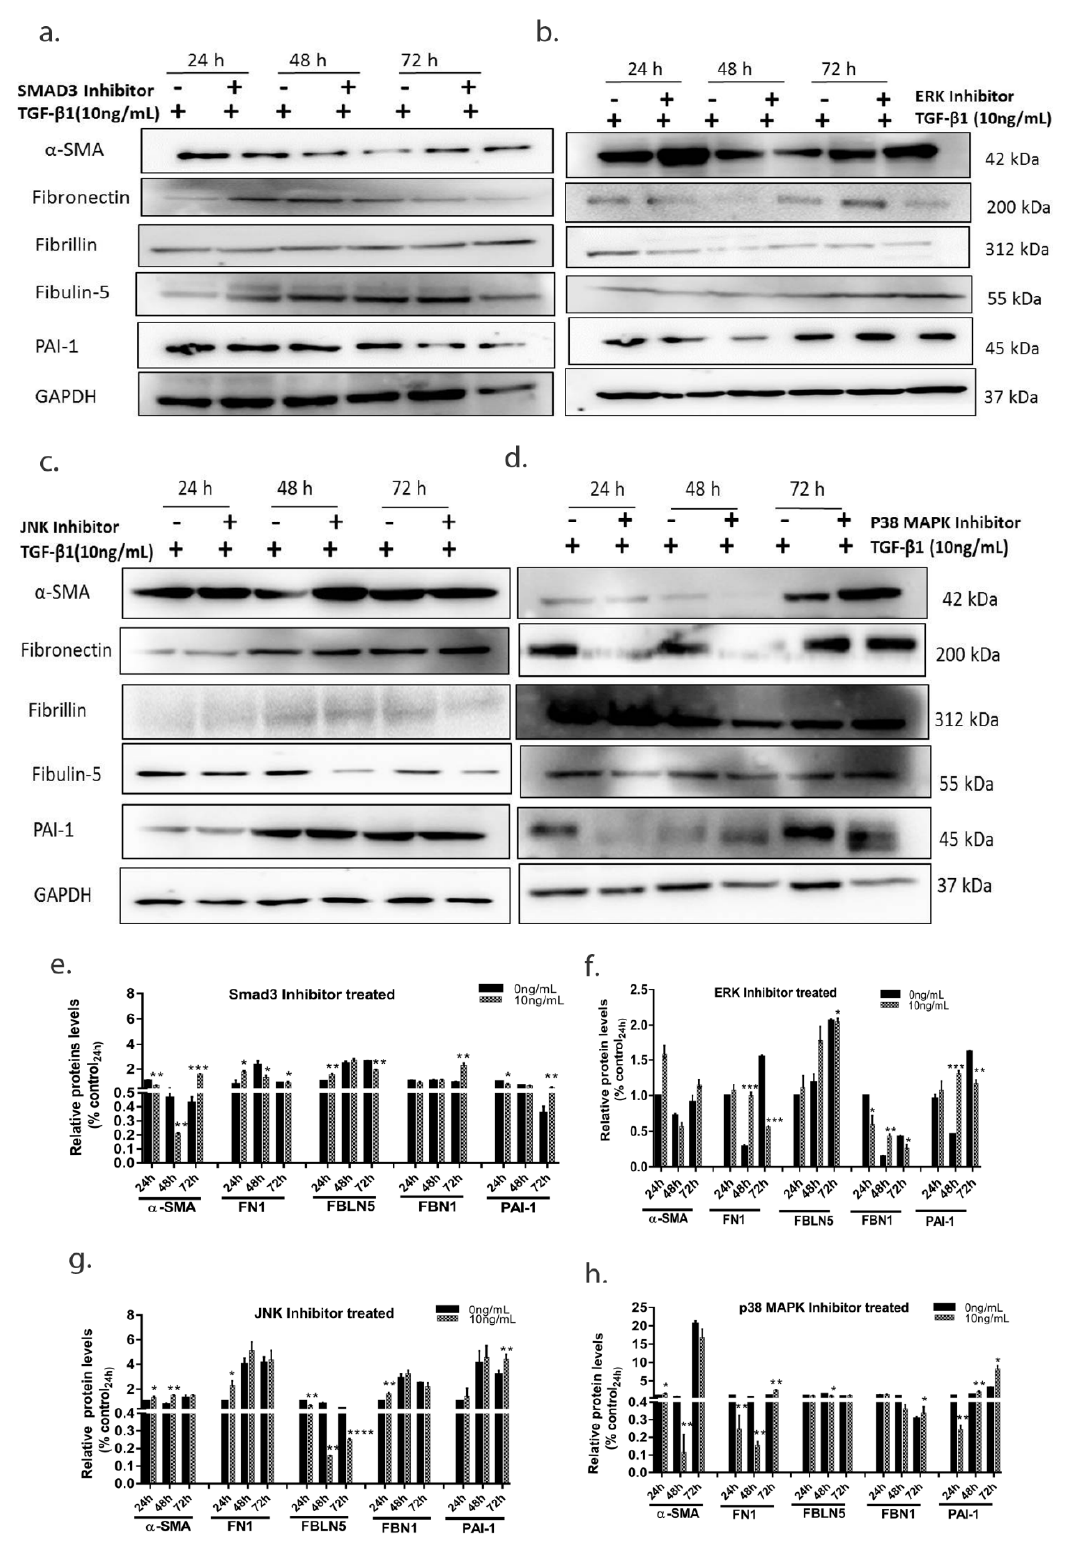
Figure 5. The effect of pharmacological inhibition of TGF canonical and non-canonical pathways. Cells treated with TGF- β 1(10 ng/mL) and with or without inhibitors were analyzed for various fibrotic protein by Immunoblotting blot after ( a ) SMAD3 inhibition. ( b ) ERK inhibition ( c ) JNK inhibition ( d ) p38 MAPK inhibition. Differential effects of pharmacological inhibition was seen on pro-fibrotic protein expression, ( e – h ) Representative densitometry analysis of the protein bands. The error bars represent standard deviation (* p < 0.05, ** p < 0.01, *** p < 0.001, **** p < 0.0001, by t -test).